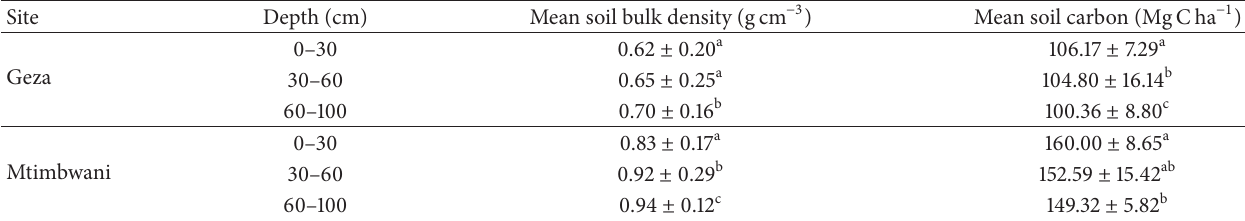
Table 3: Vertical profile of mean soil bulk density and carbon stocks (mean ± SD).